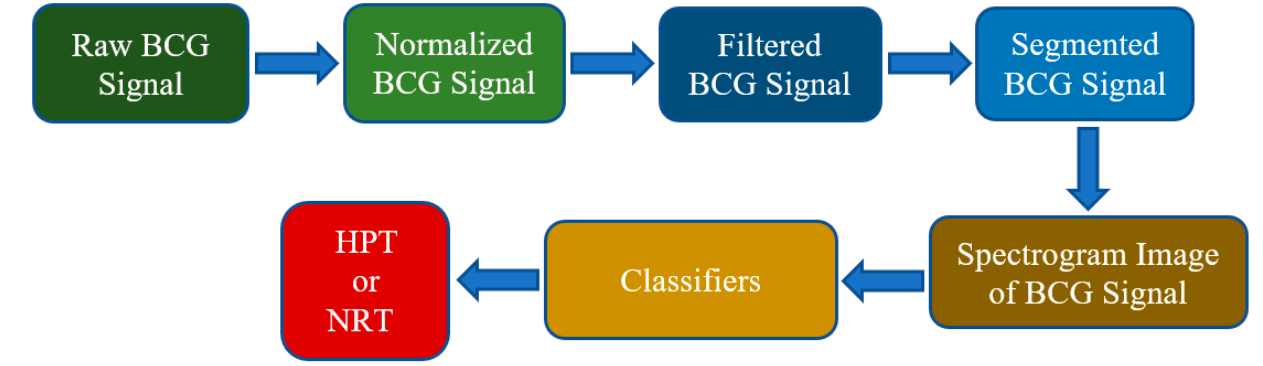
Figure 1. Proposed methodology for automatic detection of hypertension cases.